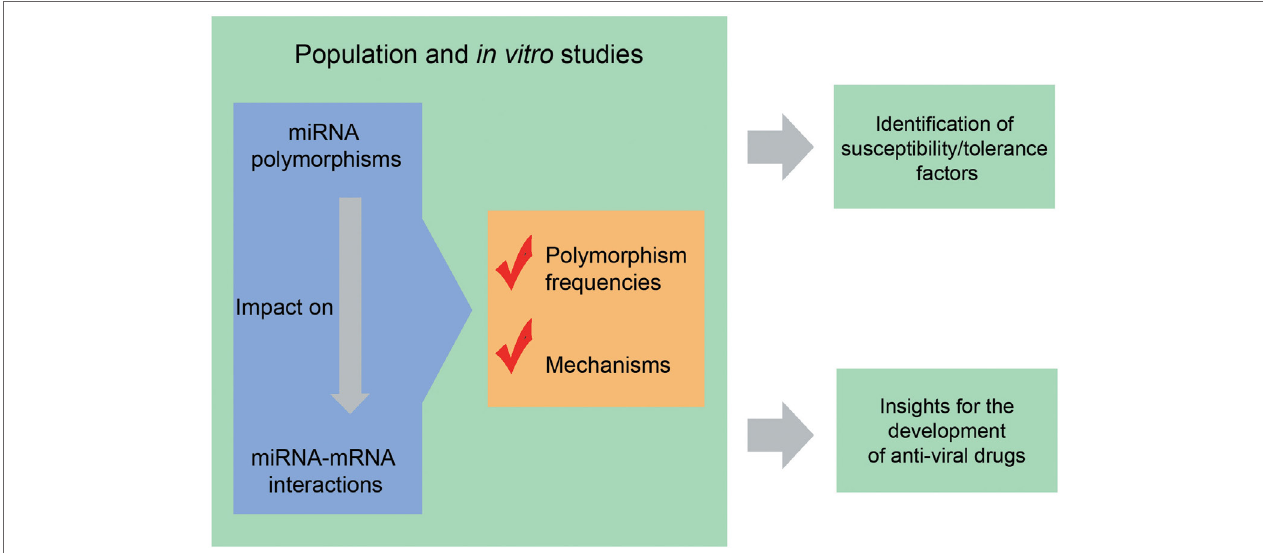
FiGURe 2 | Why to study polymorphisms in the context of viral diseases? Population or in vitro studies help to understand which and how polymorphisms impact on microRNA (miRNA)–mRNA interactions. Knowing the population distribution of polymorphisms and relationships of susceptibility/tolerance in the context of viral diseases, make it possible to identify individuals and populations with increased or decreased susceptibility to viral infections, allowing the development of strategies for infection control. In addition, the comprehension of the mechanisms by which miRNA-related polymorphisms influence the outcomes of viral diseases provides insights for the development of new antivirals. See text for